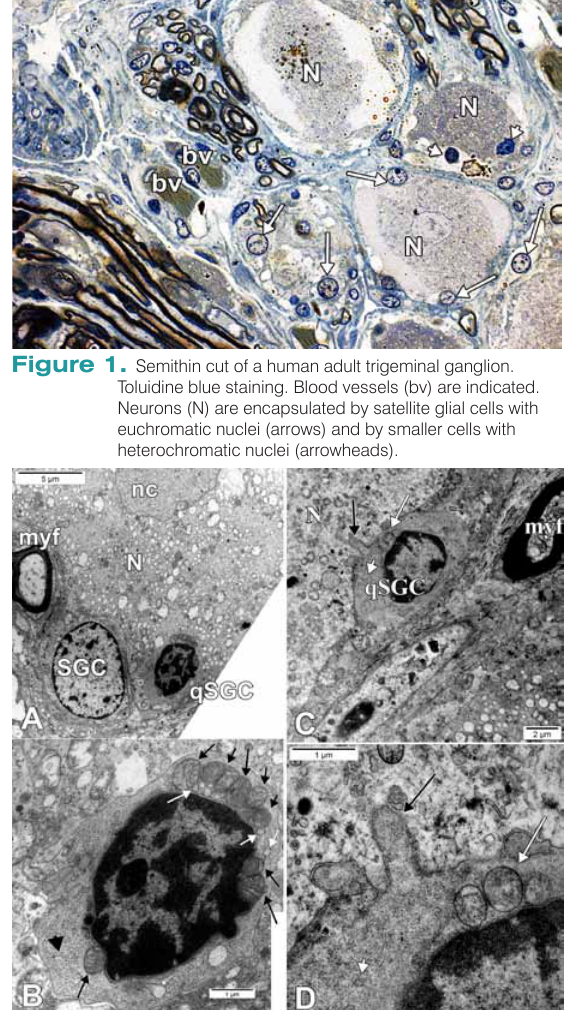
Figure 2. Ultrathin cuts of human adult trigeminal ganglia. A.General view. A trigeminal neuron (N) with its nucleus (nc) is identified, neared by a myelinated fiber (myf). A differentiated satellite glial cell (SGC) contacts the neuron and it is neared by a quiescent SGC (qSGC) with a pro- genitor phenotype, detailed in (B) at higher magnification. B.Digitally reconstructed image. The cytoplasmic content of the qSGC is uniquely represented by mitochondria (black arrow), abundant free ribosomes (black arrowhead) and scarce cisterns of rough endoplasmic reticulum (white arrows), occasionally dilated. C. A quiescent SGC (qSGC) with a progenitor phenotype contacts a trigeminal neuron (N) and form peg-and-socket junctions (black arrow). The qSGC has few mitochondria (white arrows) and abundant free ribosomes (white arrowhead). D. Detail of the neurono- glial junction in (C).